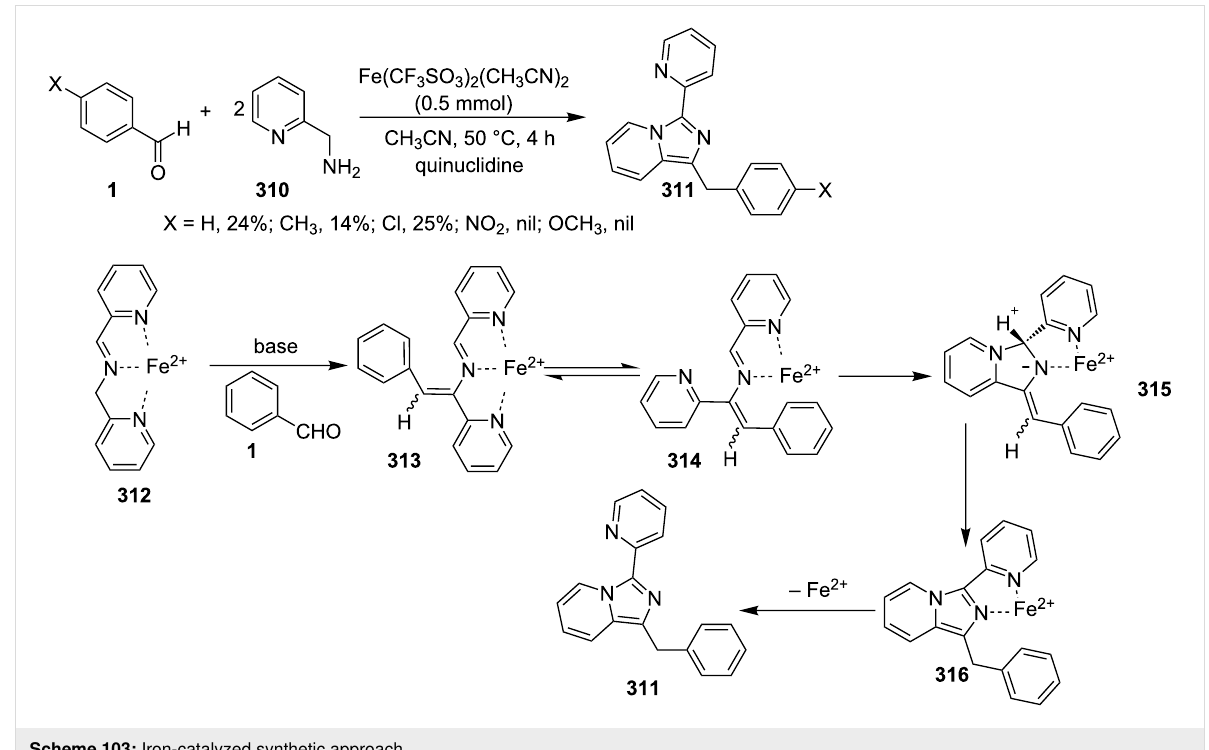
Scheme 103: Iron-catalyzed synthetic